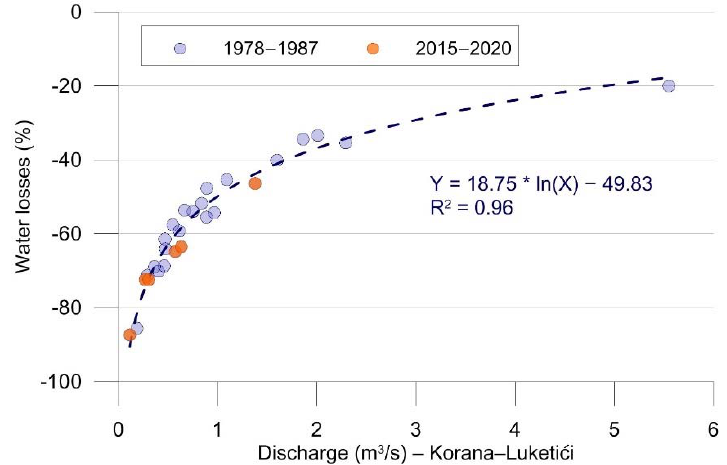
Figure 11. Correlation between the discharges measured at the Korana–Luketi ć i profile and the losses of water at the upstream section of the course (%).